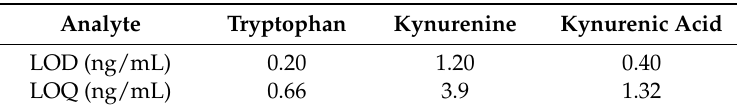
Table 2. LOQ and LOD values.